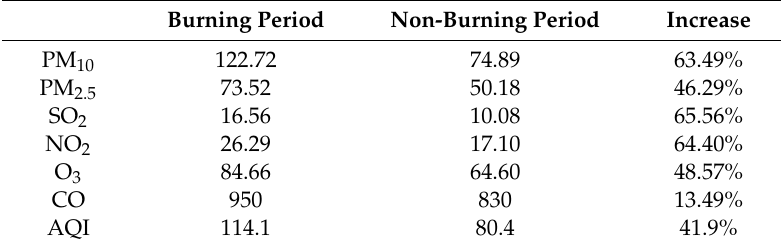
Table 4. Hourly average concentrations and increase of pollutants (PM 10 , PM 2.5 , SO 2 , NO 2 , O 3 and CO) during the burning and non-burning periods (unit: µ g / m 3